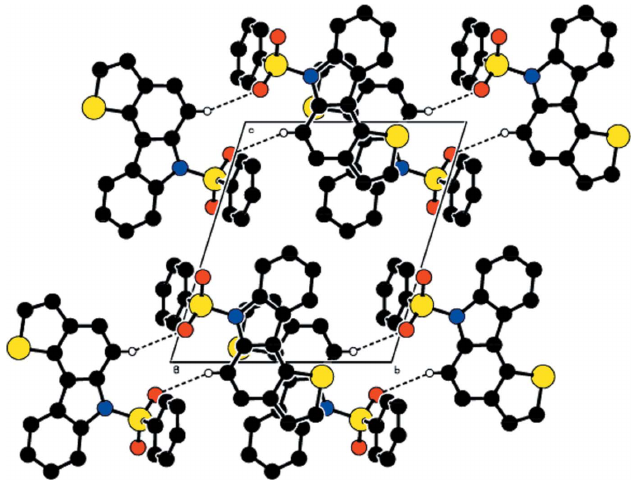
Figure 3 Hirshfeld surfaces for visualizing the intermolecular contacts of the title compound: ( a ) d norm highlighting the regions of C—H (cid:3)(cid:3)(cid:3) O hydrogen bonds, ( b ) electrostatic potential, ( c ) shape index, ( d ) curvedness and ( e ) fragment